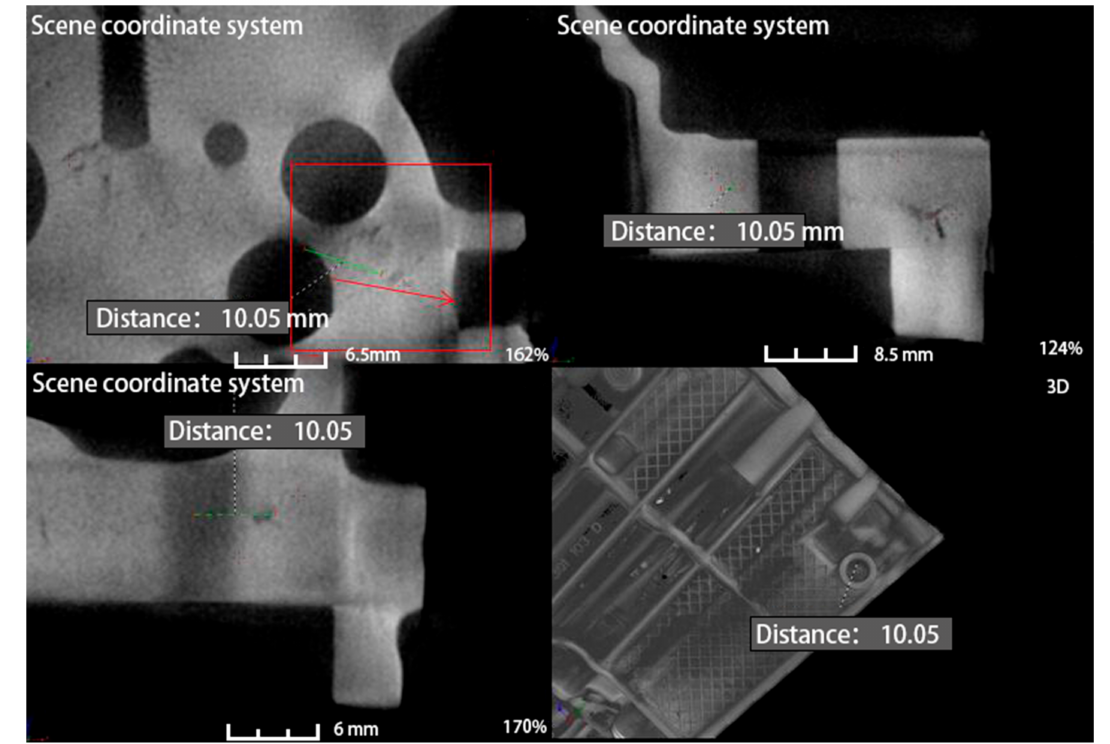
Figure 13. Results of CT measurement at the leakage site before improvement.